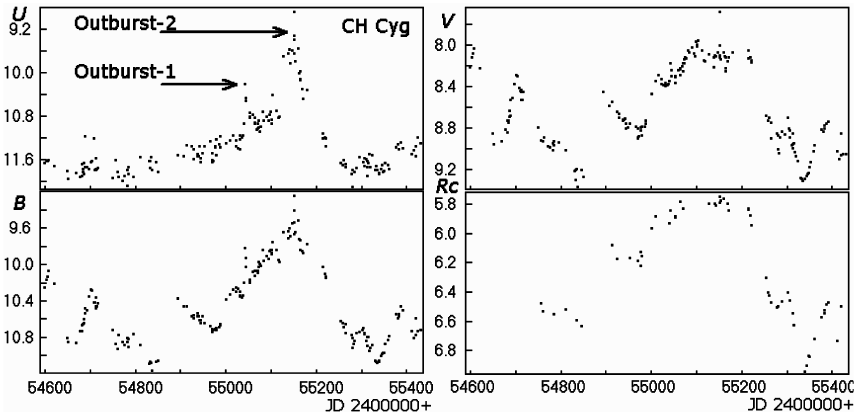
Fig. 2. UBVR C light curves of CH Cyg from 2008 to